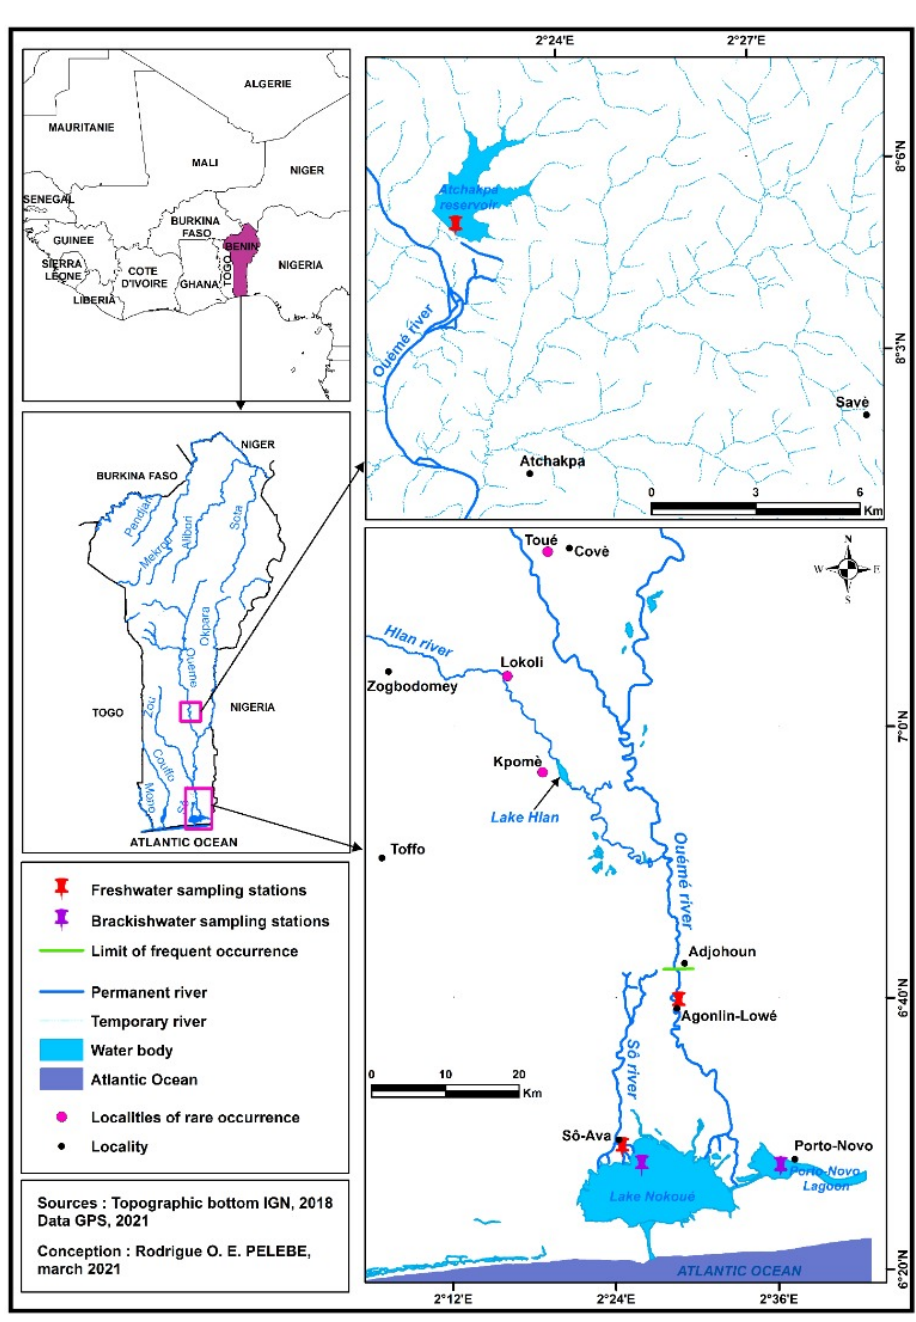
Figure 1. Hydrographic map of Benin showing the Ouémé River basin, with the location of the Atchakpa reservoir, the sampling stations, the limit of frequent occurrence and the localities of rare occurrences of S. melanotheron .